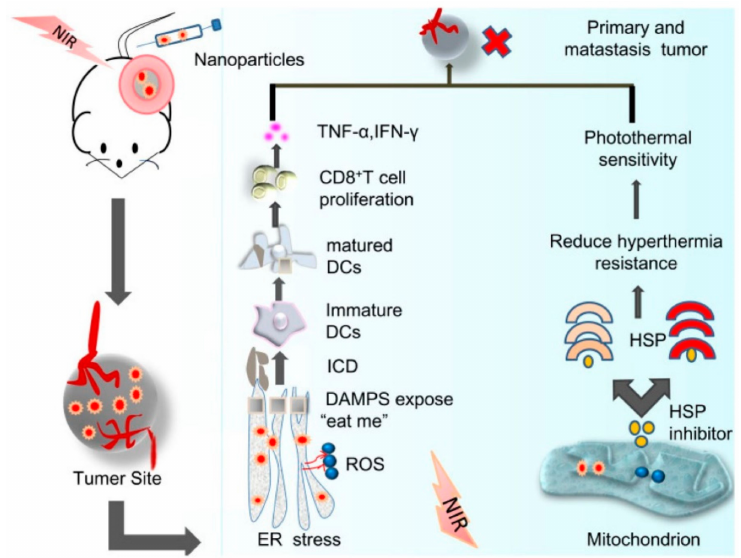
Figure 10. Possible pathways for immunogenic cell death due to the combination of PTT and PDT. Reprinted with permission from ref. [101]. Open Access Creative